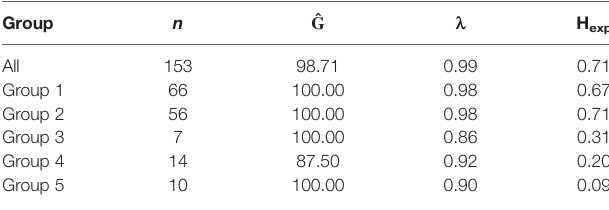
TABLE 2 | Gene, genotypic diversity and linkage disequilibrium of Australian P. nodorum isolates and its associated discriminant analysis of principal components (DAPC)